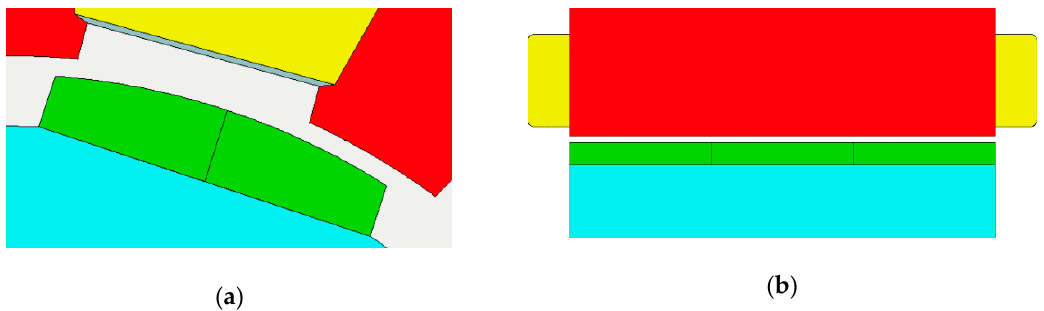
Figure 5. Magnet segmentation: ( a ) Segmentation A, parallel to the axis (two magnets per pole); ( b ) Segmentation B, parallel to the circumference (three magnets per pole).